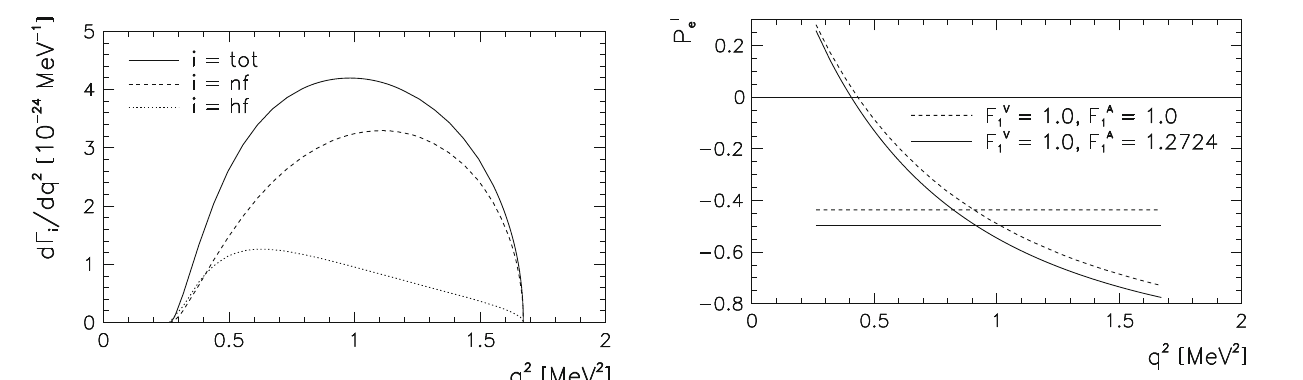
( 1 + ( F V / F A ) 2 )δ ( z . r .) where the zero-recoil value of δ e 1 1